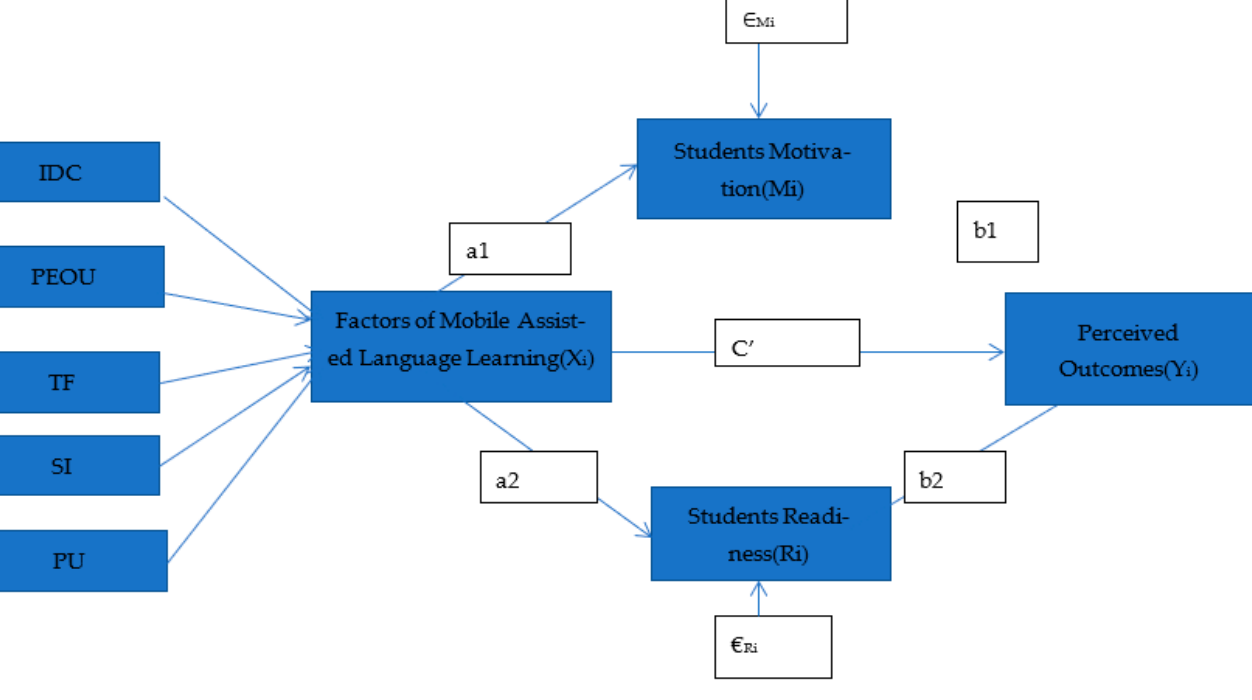
Figure 1. Proposed Research